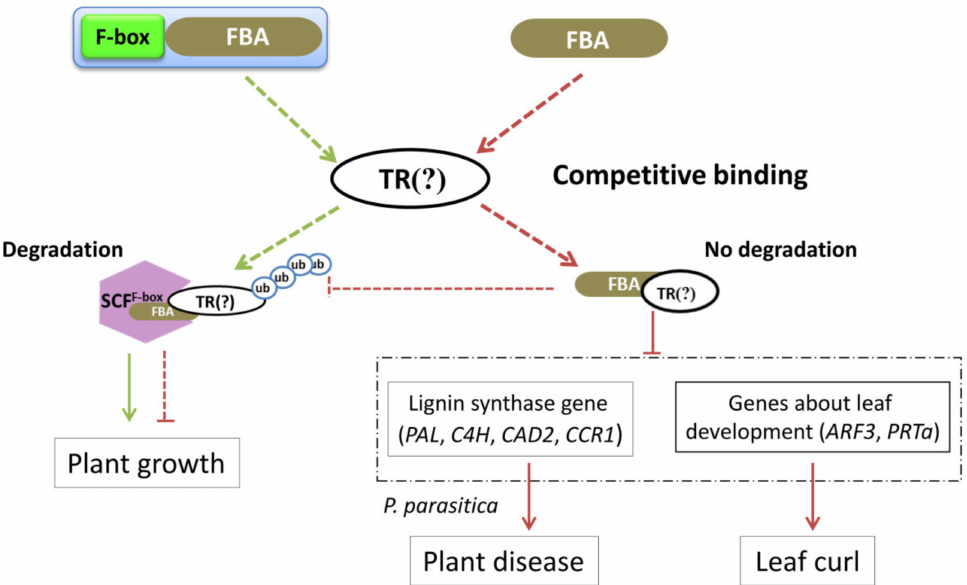
Figure 9. Putative model of FBA gene regulation of plant growth. Green lines represent the false regulatory pathway of the FBA gene containing the F-box protein, and red lines represent the regulatory pathway of the FBA gene containing only the FBA domain. The T-lines and arrows indicate inhibition and promotion, respectively. Solid line: red is the result of our experiment, green is the result of previous studies; Dotted line: the pathway we speculate. TR(?): unknown target transcription repressors, SCF: the complex of SKP1, CUL1 and